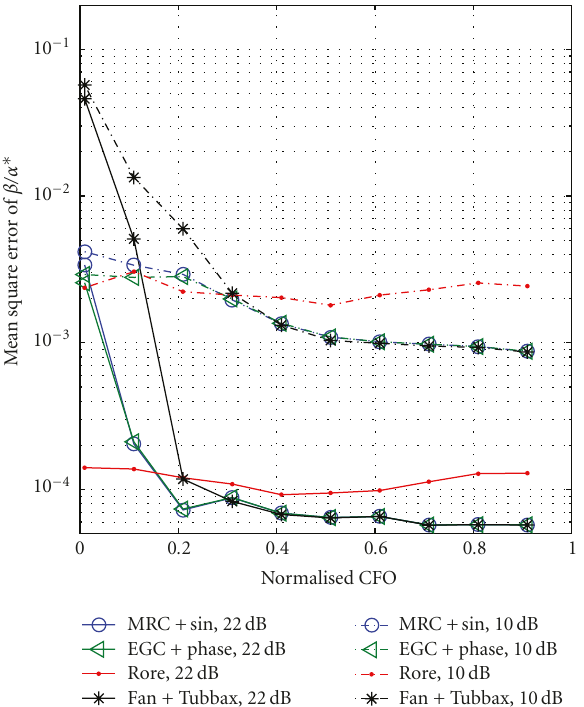
Figure 6: MSE of β/α ∗ at SNR = 10 dB and 22dB in the presence of 2dB gain mismatch and 5 ◦ phase